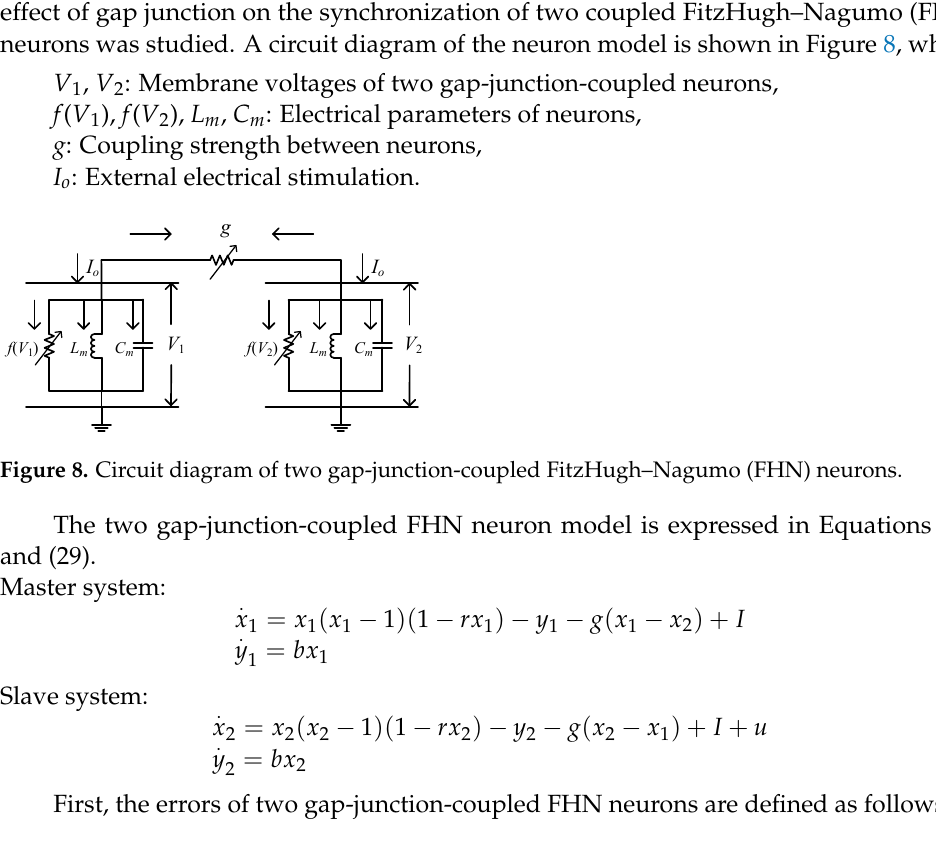
Figure 7. e x − e y plane of signed distance.